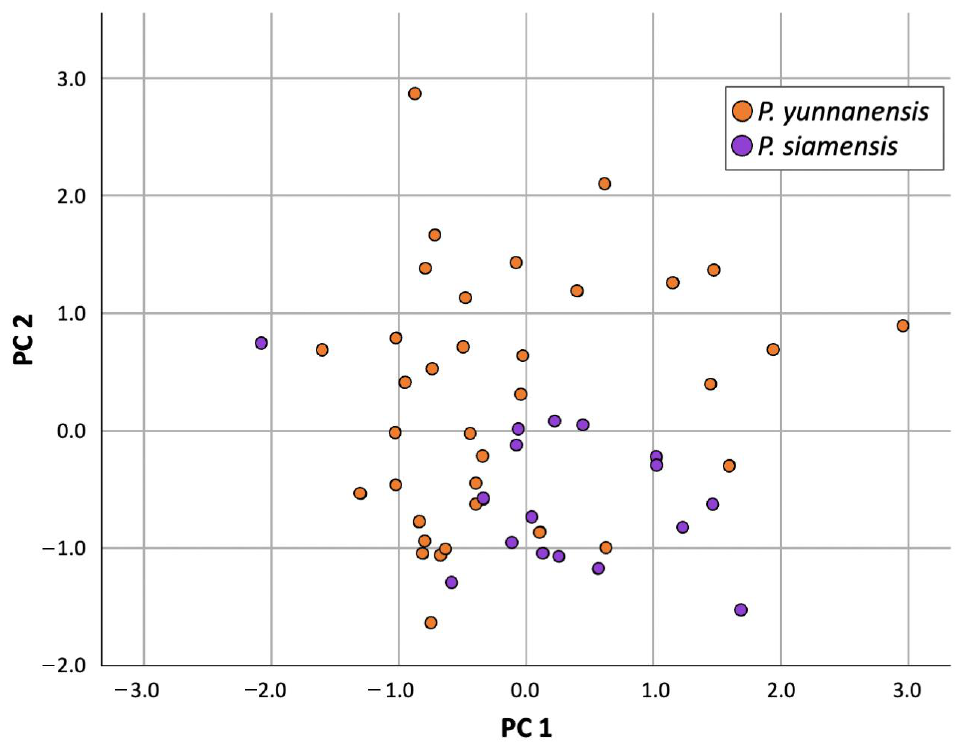
Figure 7. Principal Component Analysis results (PC1, PC2) of P. yunnanensis and P. siamensis in the non-flowering state.